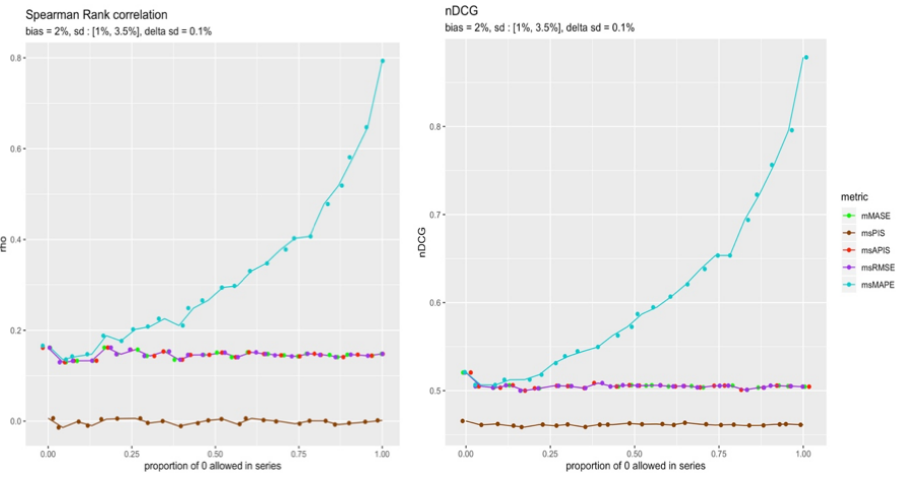
Figure 22. Reliability of series in function of the level of intermittence.